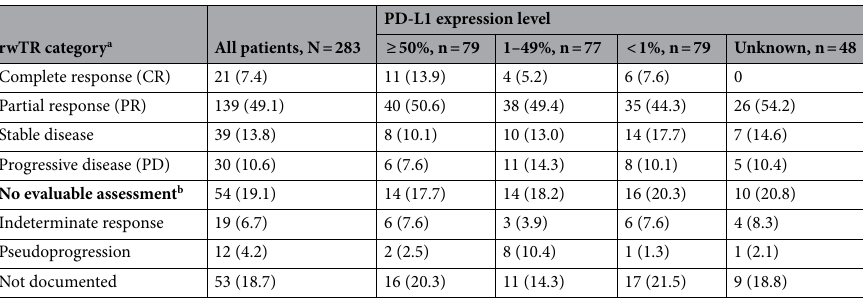
Table 3. Best real-world tumor response (rwTR) to first-line pembrolizumab plus pemetrexed-carboplatin. Data are n (%). Percentages may not add up to 100 because of rounding. a For patients with multiple real-world tumor response (rwTR) assessments, the best response was used (CR > PR > stable disease > PD). b Patients without an evaluable rwTR assessment are counted in the ‘no evaluable assessment’ response category and may be counted more than